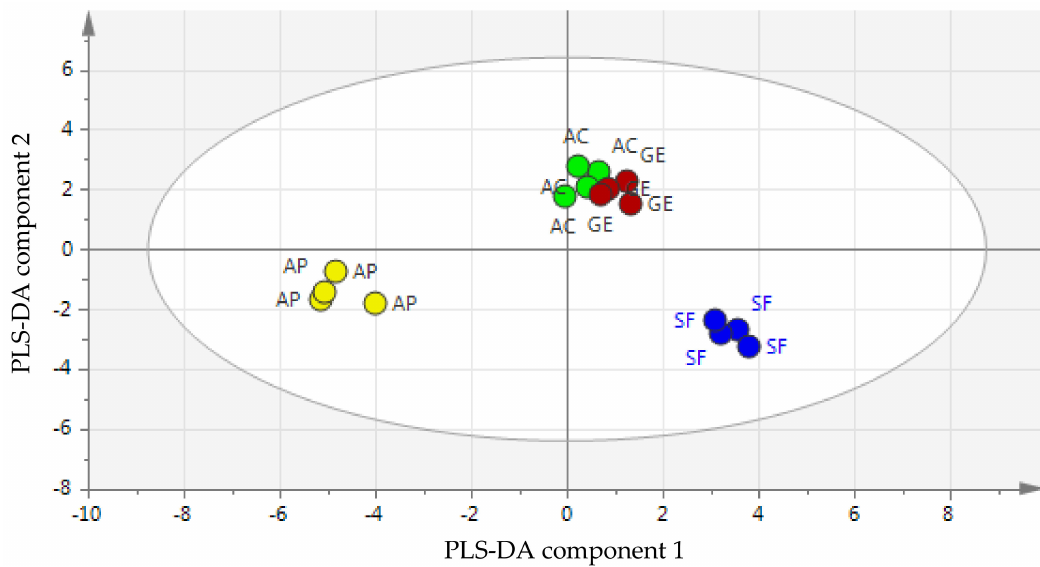
Figure 2. The Partial Least Squares-Discriminant Analysis (PLS-DA) score plot of amino acid data. Coloured circles are represented by AC = acacia honey (green); GE = gelam honey (red); SF = starfruit honey (blue) and AP = Apis honey (yellow).